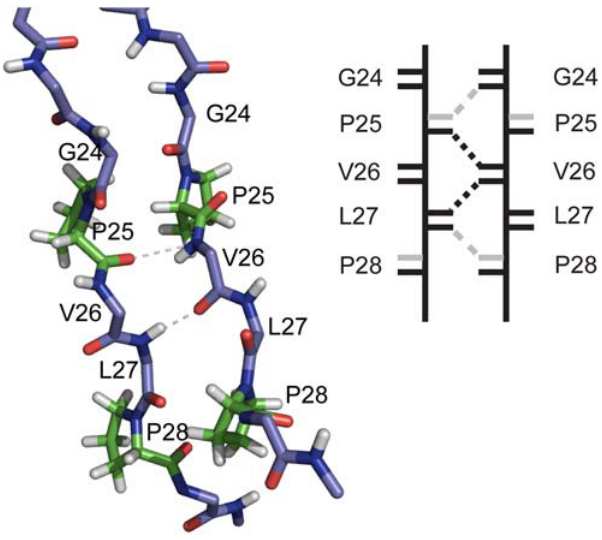
Figure 6. Backbone hydrogen bond interaction on C-terminal region of two strands of rIAPP. Only mainchains of residues (except four prolines) are shown in stick by PyMOL package. Four prolines (two P25, and two P28) are shown in green color. Hydrogen bonds between Val26 and two interstrand residues Pro25, Leu27 are presented as dash lines. The right illustrative figure gives a simple demonstration of hydrogen bonding network of the structure. Short black lines indicate hydrogen bond donors (amino groups) and acceptors (hydroxyl groups); short grey lines indicate the missing hydrogen bond donors on prolines. The real hydrogen bonds in structure are shown in black dash lines on the right; the grey dash lines show the missing hydrogen bonds which are supposed to form between prolines and their partner residues.